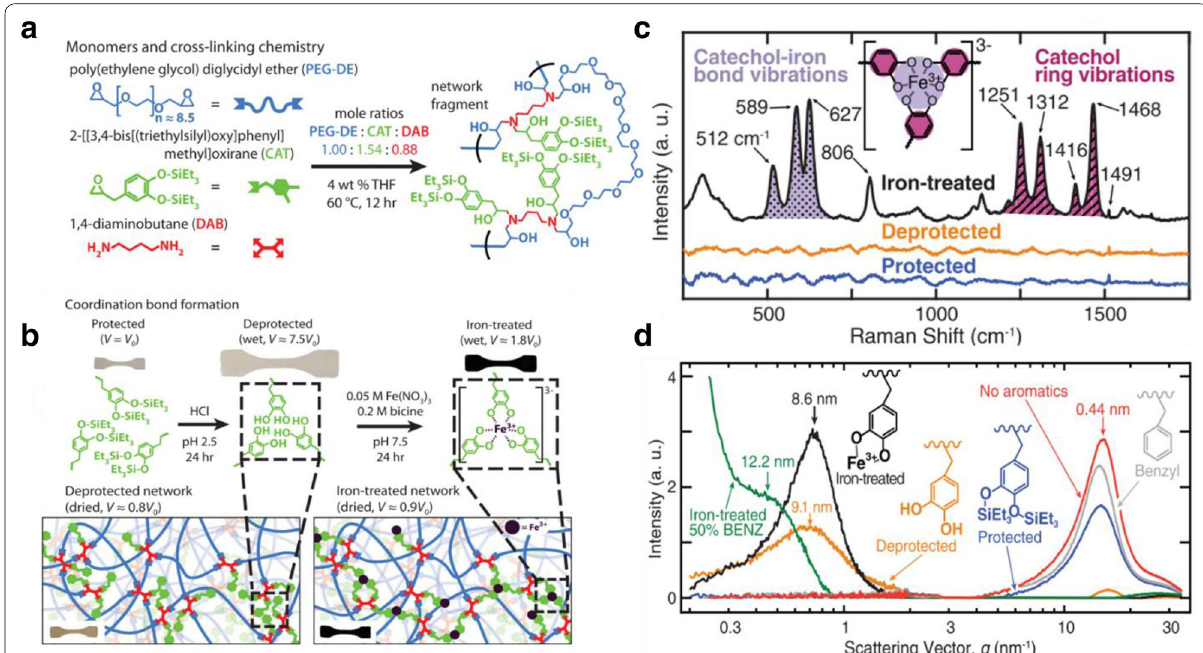
Fig. 8 a Synthesis of catechol-containing networks and a triethylsilyl protected catechol group (CAT) cluster network-formation chemistry; b schematic representation of the silyl protective group’s cleavage and subsequent iron complex formation and a test specimen swelling during the process; c Raman spectra of protected (blue), deprotected (orange), and iron-treated (black) catechol-containing networks, which is confirm iron-catechol coordination; d SAXS and WAXS of the dry networks. SAXS shows broad peaks for the deprotected (orange) and iron-treated (black) networks. WAXS peaks result from interatom matrix scattering (reproduced with permission from: Ref. [64] ©2017,